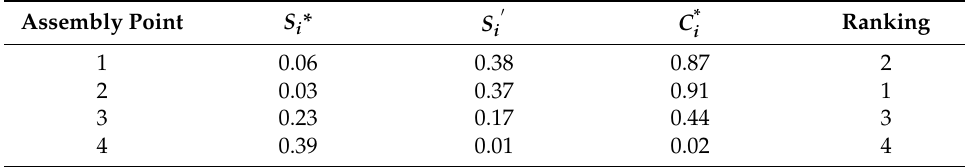
ranking from IEW and TOPSIS. i